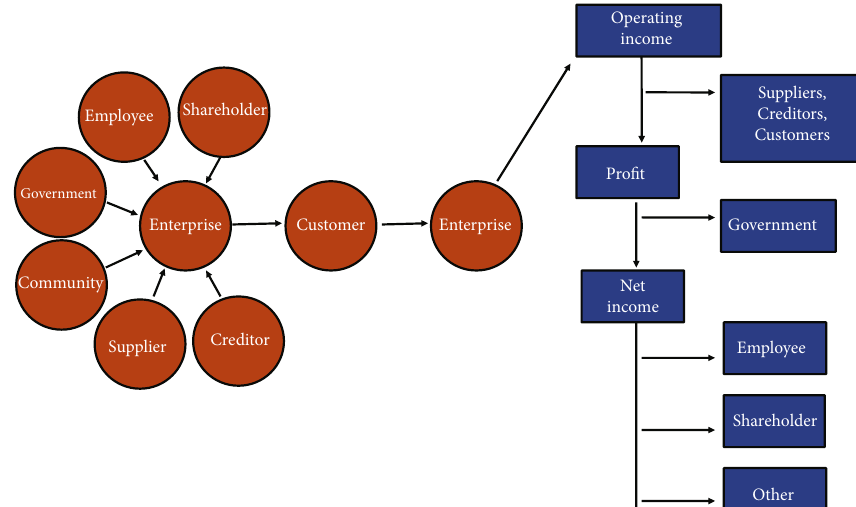
Figure 2: Enterprise input-output-operation model.